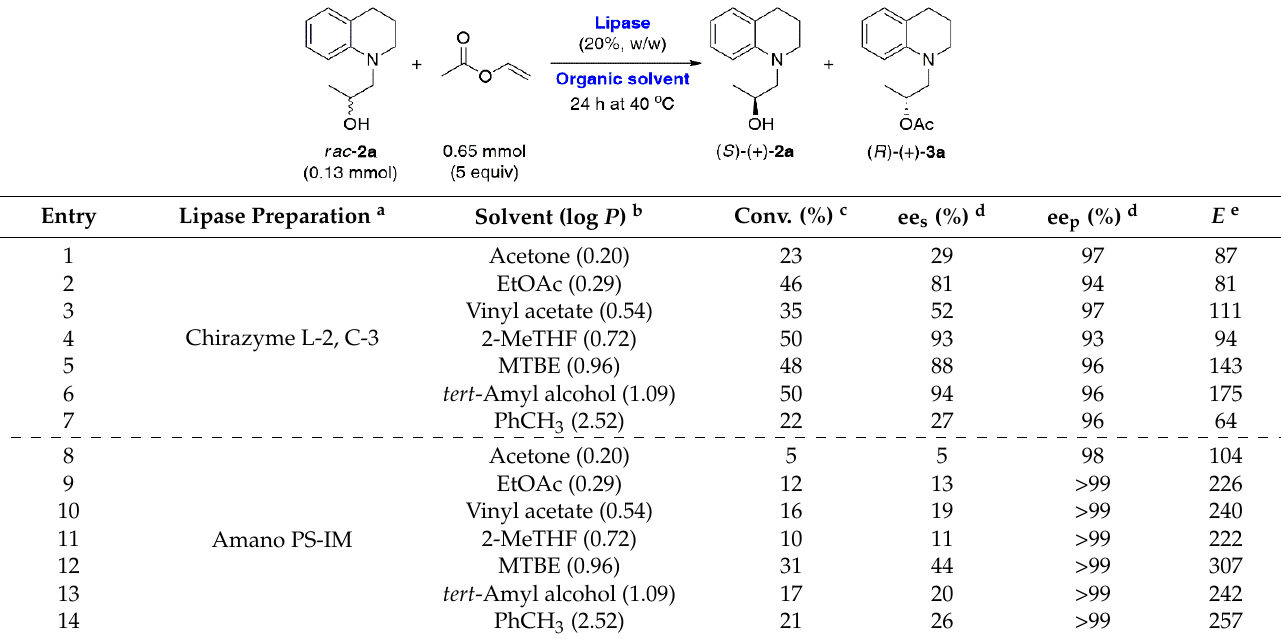
Table 2. Co-solvent screening for lipase-catalyzed KR of rac - 2a with vinyl acetate.